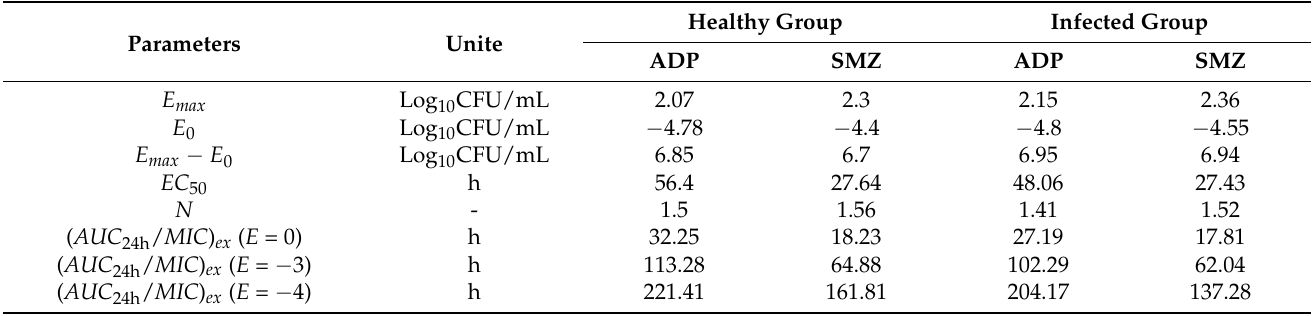
Table 7. The Sigmoid E max model result in PELF after intramuscular injection ADP/SMZ injection at 5/25 mg/kg